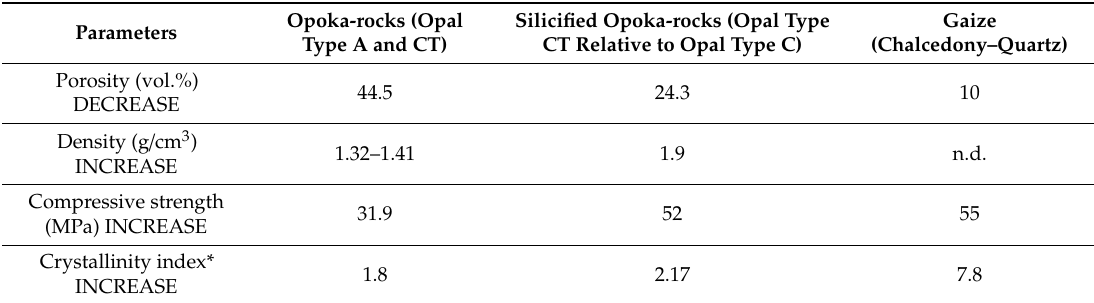
Table 1. Rocks accompanying the Bełchat ó w lignite deposit with dominant SiO 2 -group mineral and designated parameters [39].